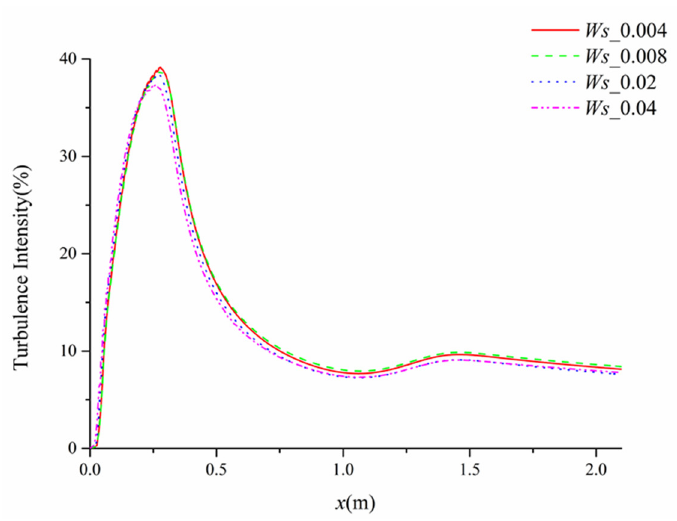
Figure 16. Axial turbulence intensity under different inlet particle mass flow rates.